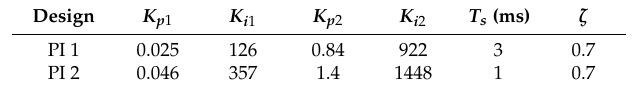
Table 3. Two-loop PI current-mode control designs and specs.